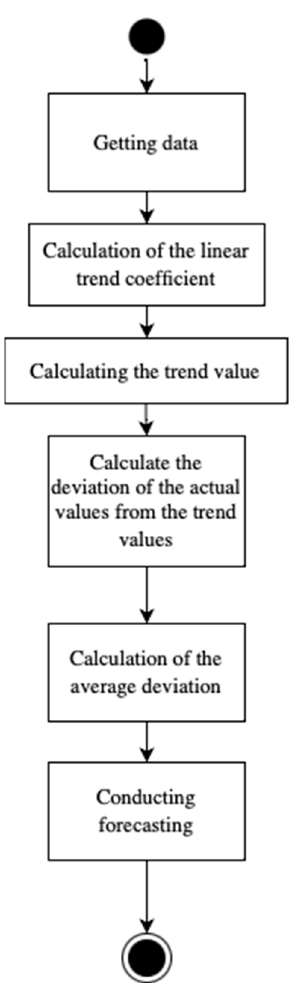
Figure 4. Forecasting algorithm with growth and seasonality coefficients.